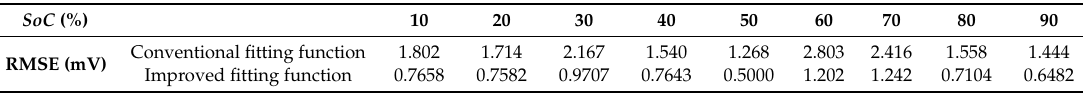
Figure 11. R long estimation results. Table 3. Comparison of RMSE at different SoC